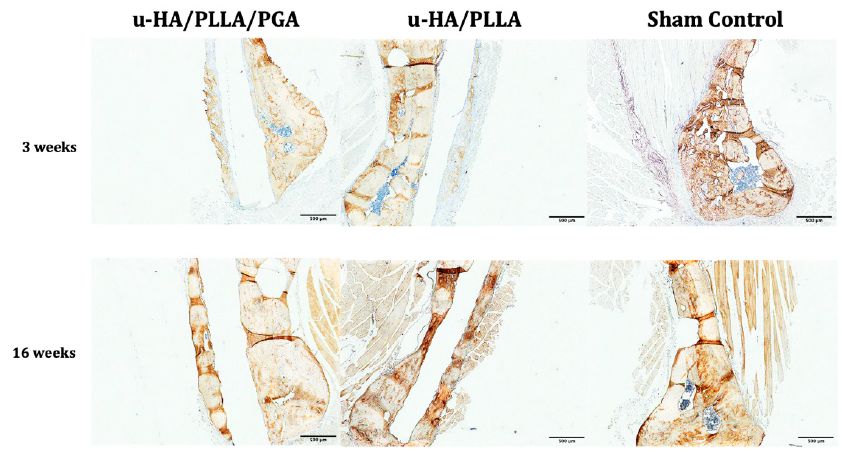
Figure 10. OCN expression in the u-HA/PLLA/PGA subgroup, u-HA/PLLA subgroup, and sham control. All images were taken at 4× magnification. Scale bar: 500 μ m.